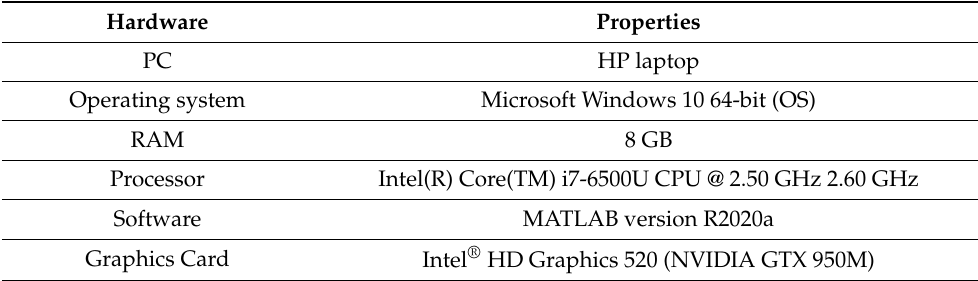
Table 1. Experimentation Properties